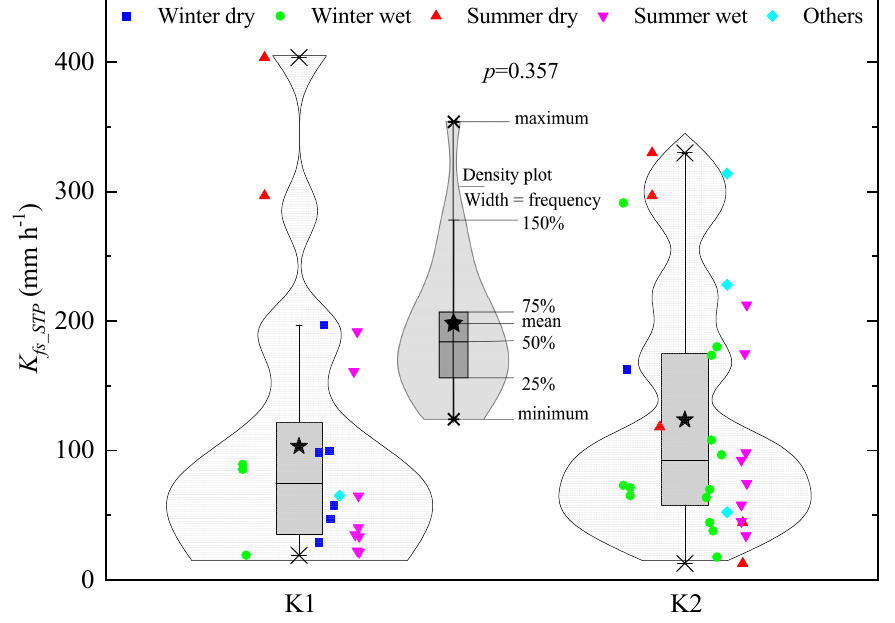
Figure 9. Viscosity-corrected field-saturated hydraulic conductivities ( K fs_STP ) in the cropland without (K1) and with (K2) irrigation, including a total of 23 and 29 valid measurements, respectively, during the experimental period.